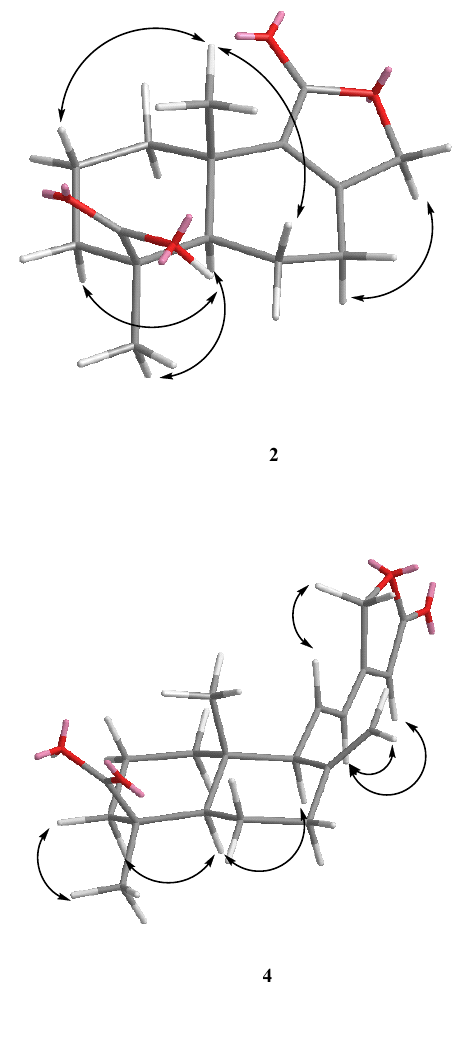
Figure 2. Key COSY ( ▬ ) and HMBC ( → ) correlations of 1 ‒ 7 .